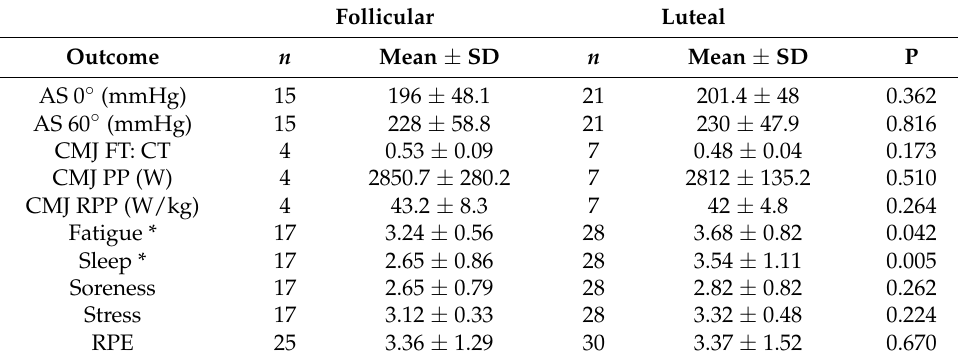
Table 1. Performance, fatigue and wellbeing outcomes in the follicular and luteal menstrual cycle